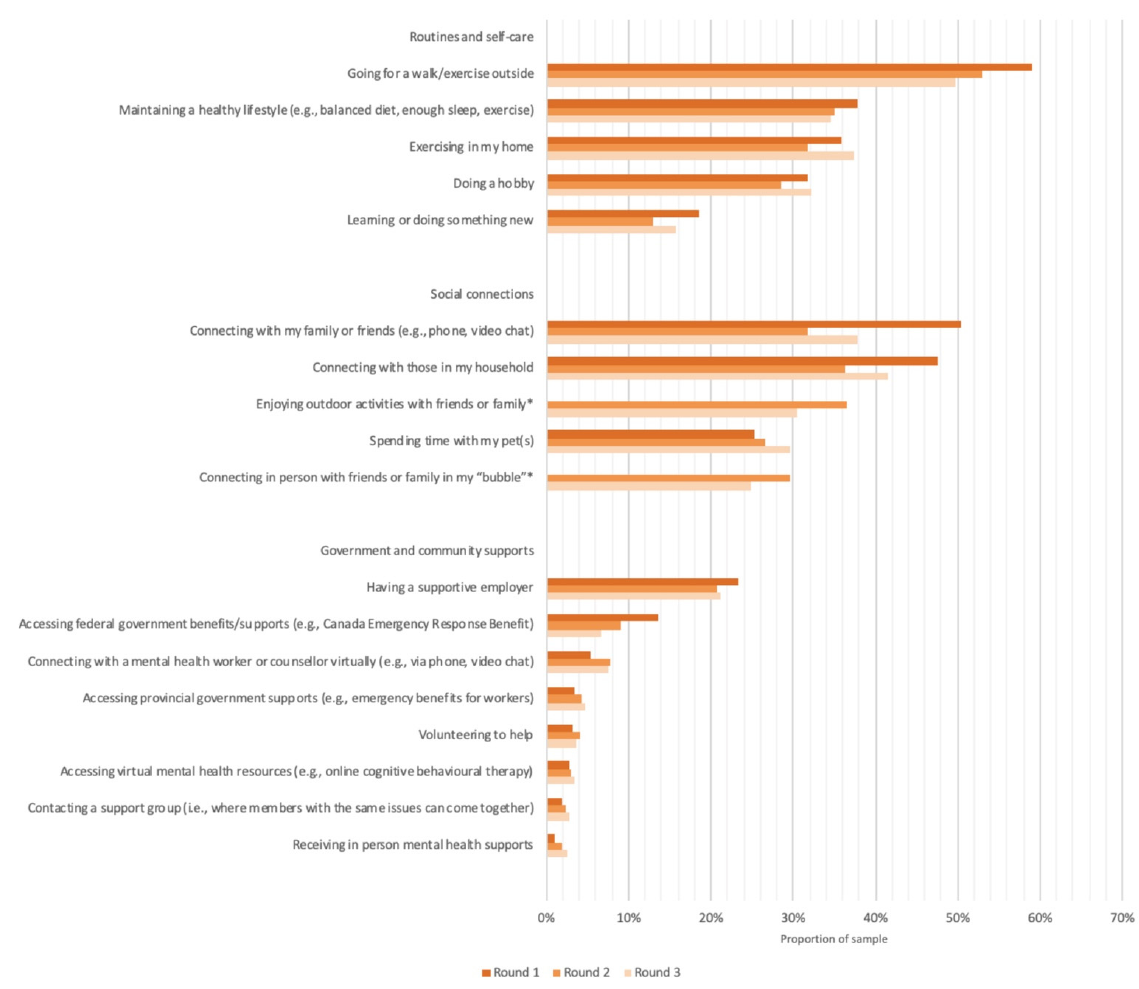
Figure 3. Parent-identified supports for coping with stress related to the COVID-19 pandemic in the past 2 weeks. * Survey item not asked in round 1.